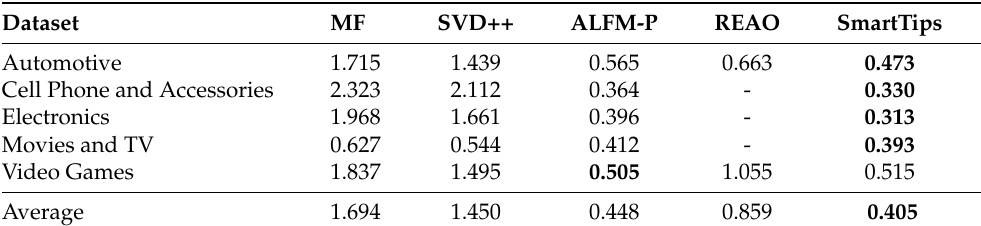
Table 2. Comparisons results of the proposed SmartTips model in terms of the rating predictions with the baseline